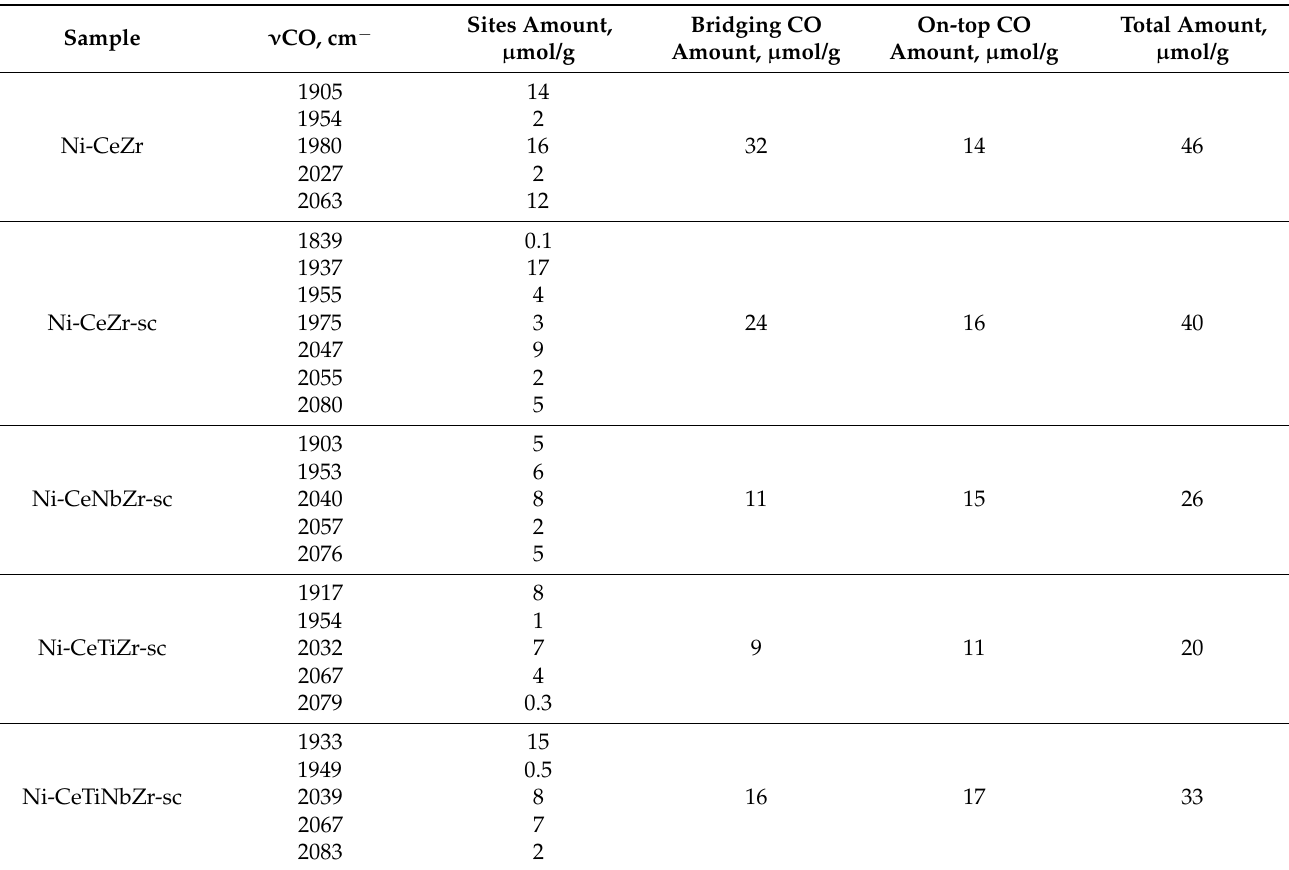
Table 4. Concentration of various type of surface carbonyls according to IR